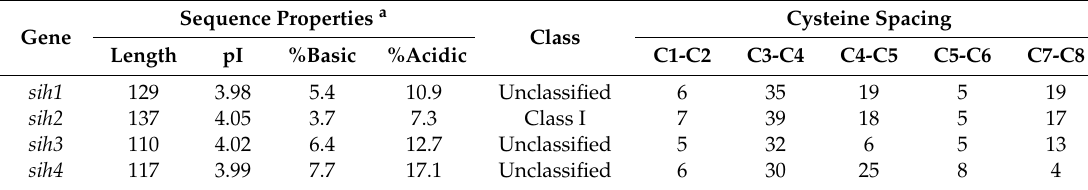
a —of mature protein without signal